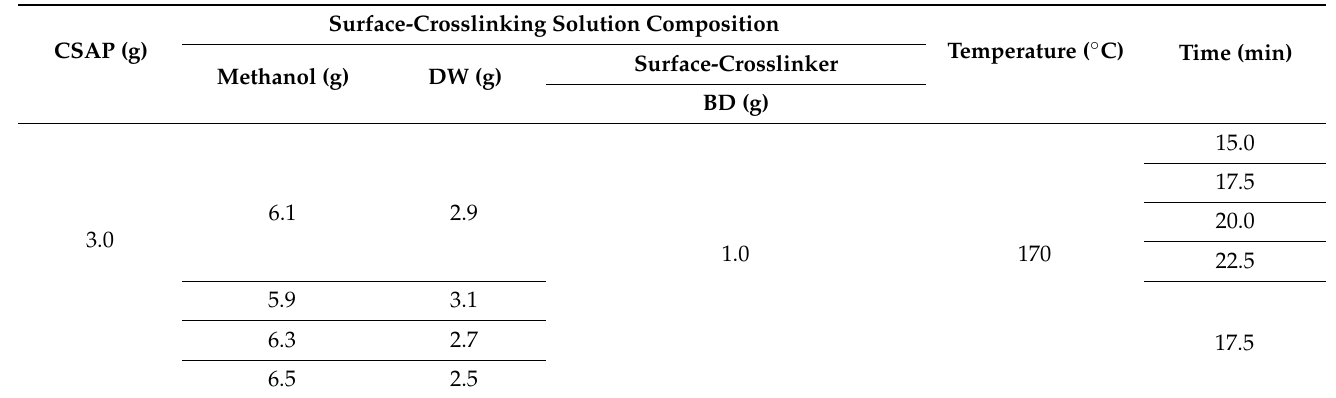
Table 2. Surface-crosslinking